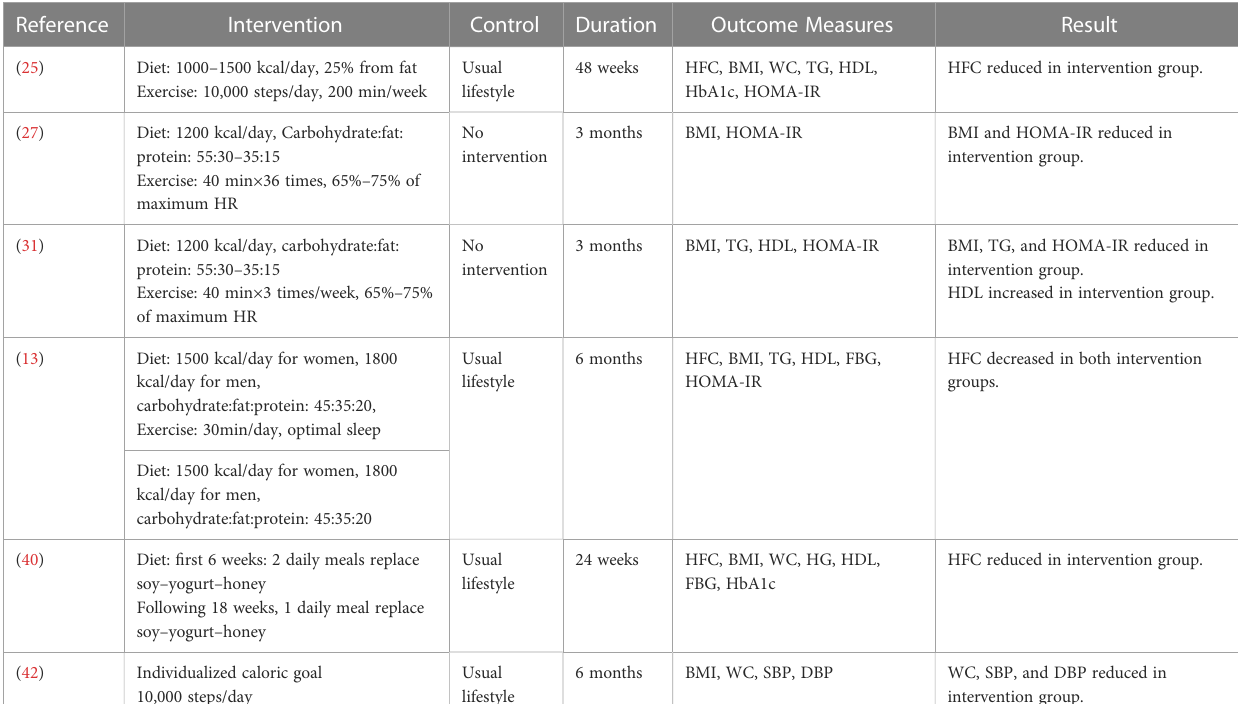
TABLE 5 Diet combined with exercise